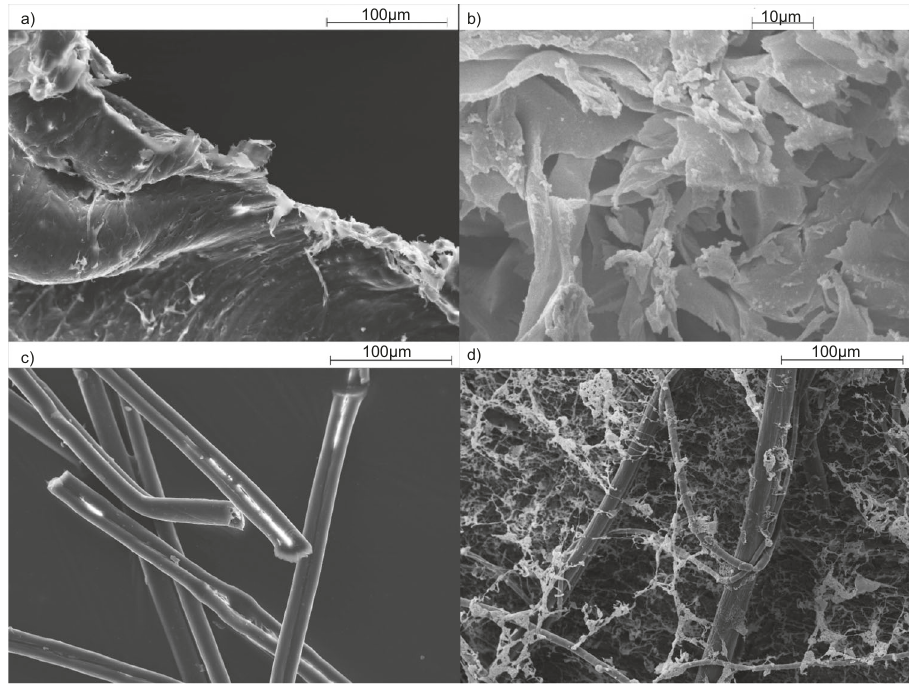
Fig. 1 SEM images of microplastics before and after bio fi lm colonisation. a Clean polyethylene terephthalate (PET), b bio fi lmed PET, c clean nylon, polyester and acrylic (NP&A) fi bres and d bio fi lmed NP&A fi bres. Note the scale in b is different than in a , c , d due to the higher magni fi cation needed to visualise the bio fi lmed